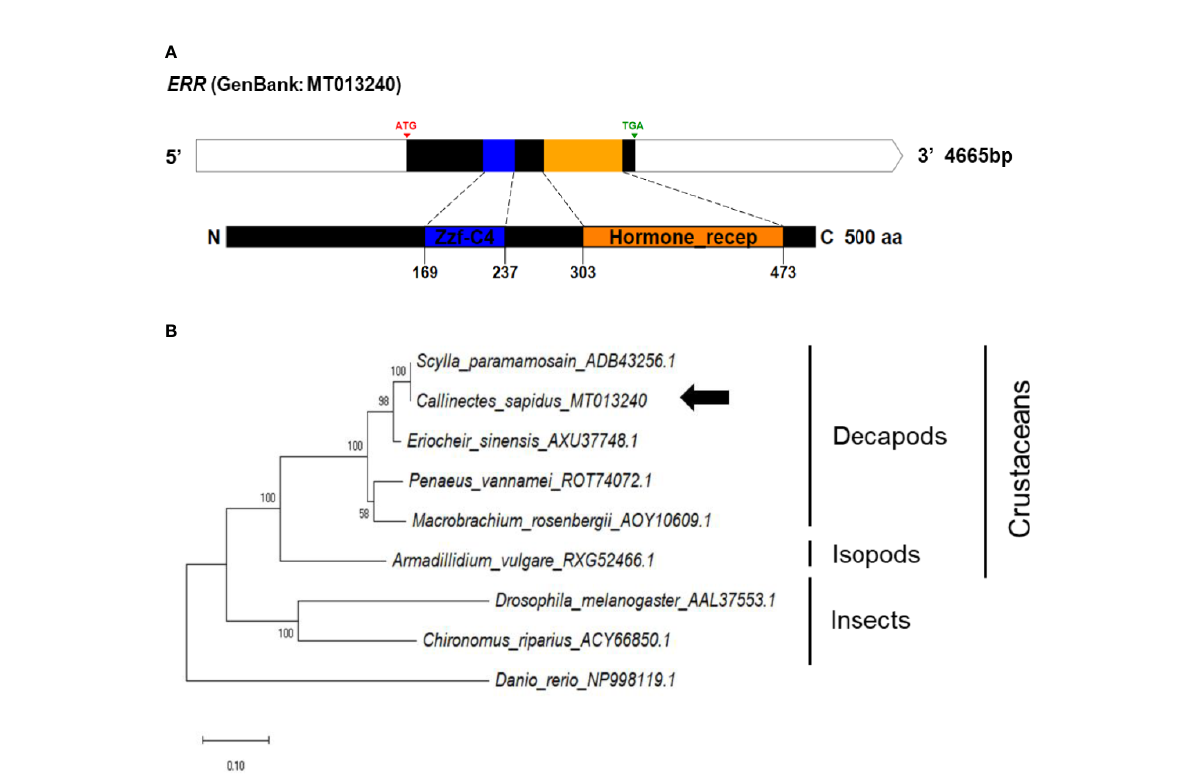
FIGURE 6 (A) Schematic representation of C. sapidus ERR . The conserved domains of ERR protein are shown in different colors (zf-C4: zinc fi nger, C4 type; hormone receptor: ligand-binding domain of nuclear hormone). (B) Phylogenetic tree of ERR was constructed using neighbor-joining (NJ)